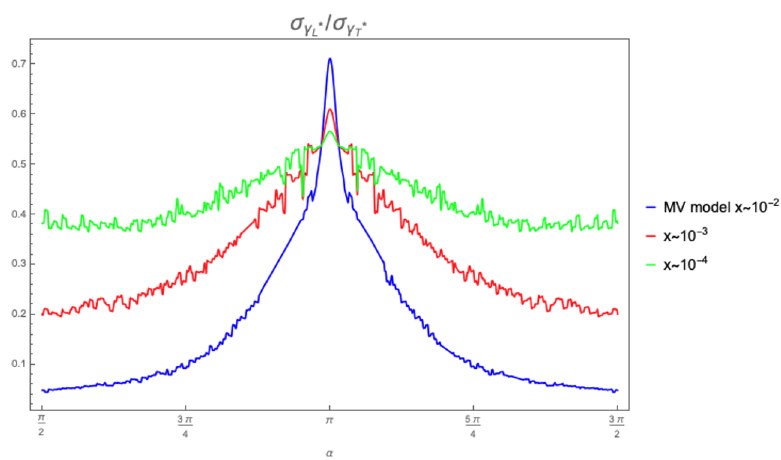
Figure 3 . Ratio of the γ ∗ A → Q ¯ QX and γ ∗ A → Q ¯ QX cross sections, calculated in the ITMD L T framework and as a function of the angle α between the transverse momenta of the heavy quarks. Gluon TMDs are numerically evaluated in the MV model and evolved towards lower values of x with the JIMWLK equations.